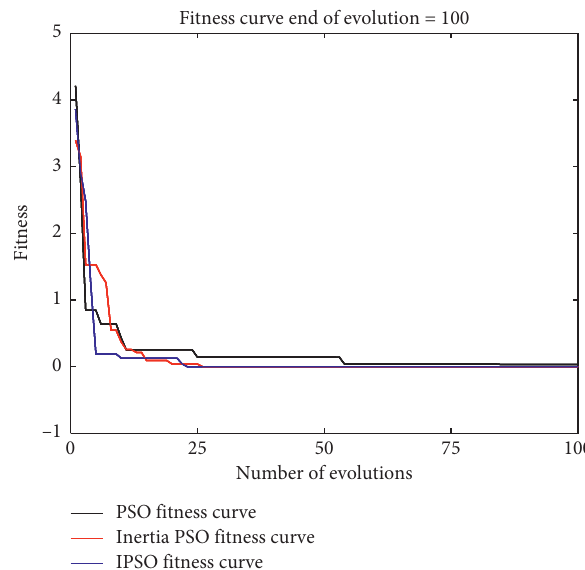
Figure 3: The fitness curves of PSO, inertia weights PSO, and IPSO